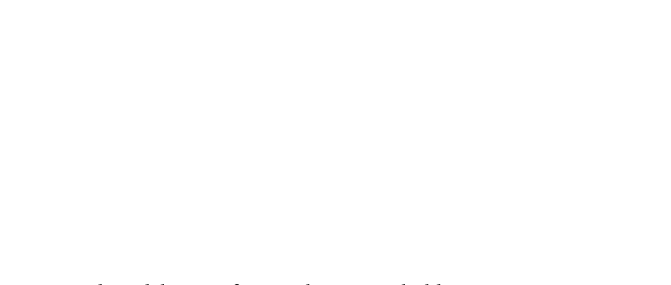
Figure 5. REC curve for: ( a ) training and ( b ) testing datasets.